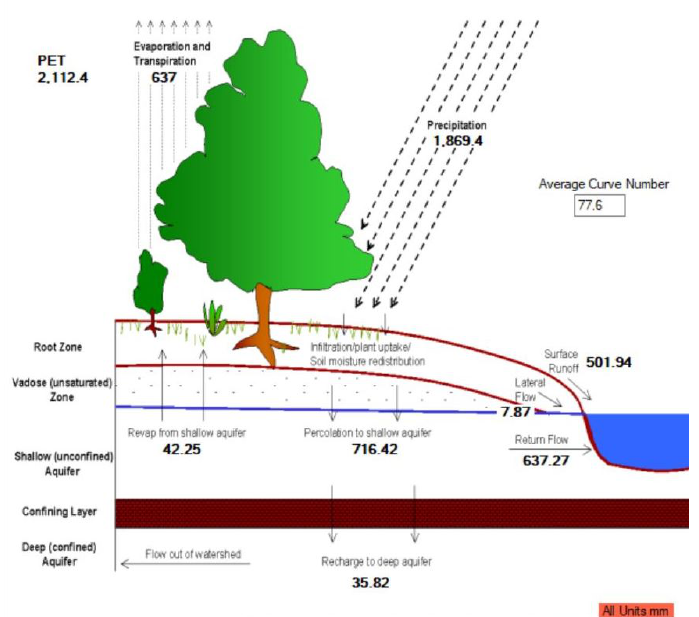
Figure 4. Hydrological scenario of Gandheshwari basin (All units are in mm).